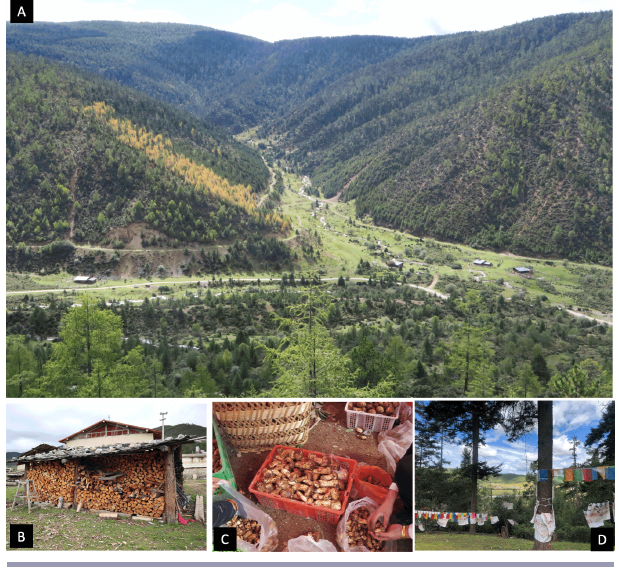
Fig. 3 . The multifunctionality of forest (A), for fuelwood (B), for commercial non-timber forest products (C), and for religious. needs